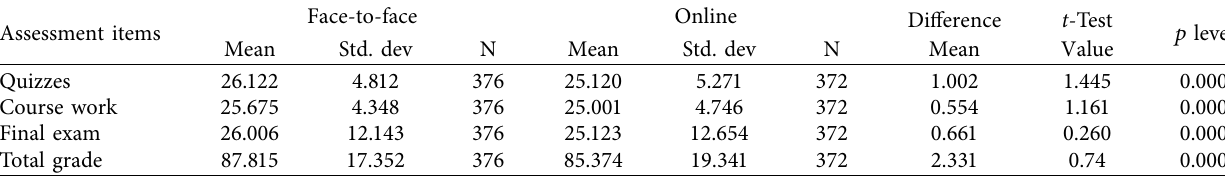
Table 2: Comparison of course grades.